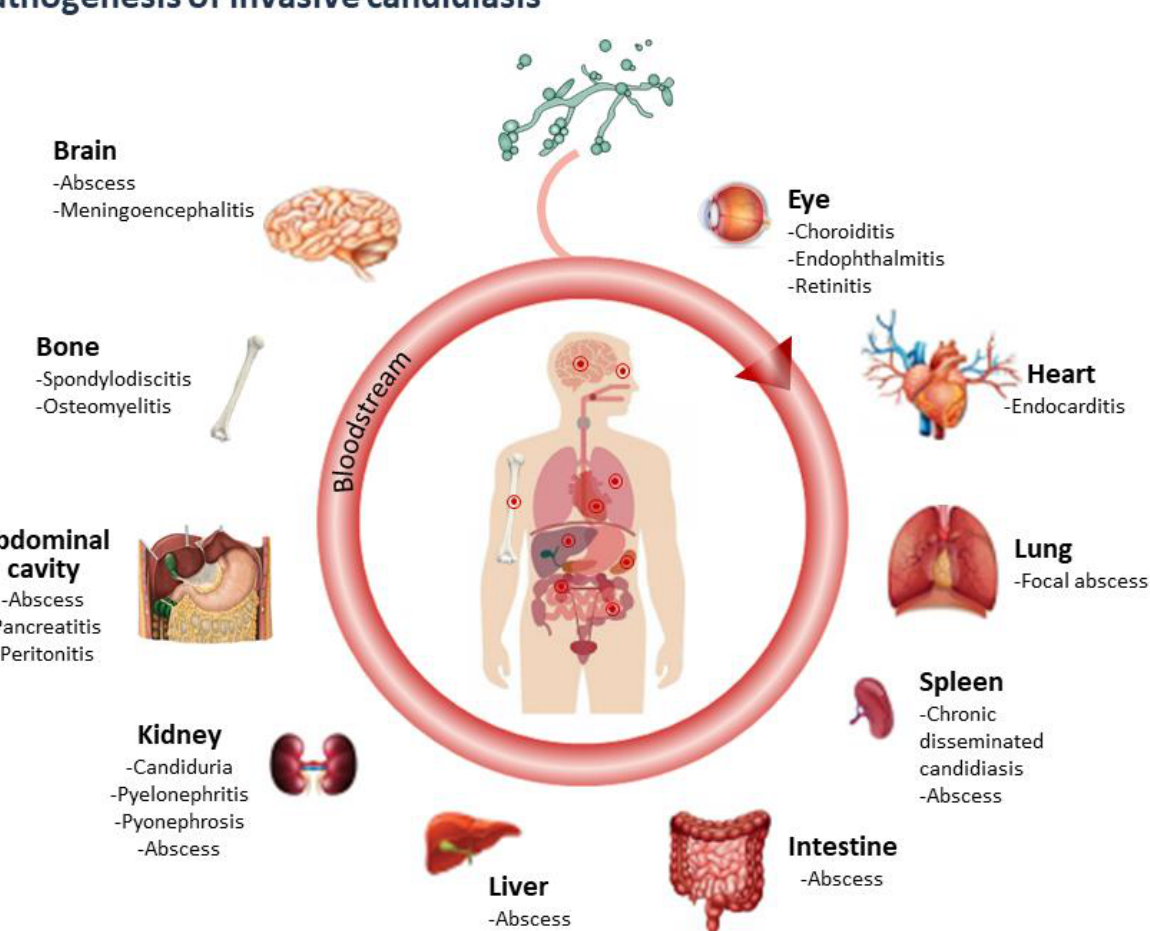
Figure 3. Invasive Candidiasis: Organs Susceptible of Infection by Candida spp. and Resulting Diseases. The names of diseases agree with those described by Pappas et al. [12].